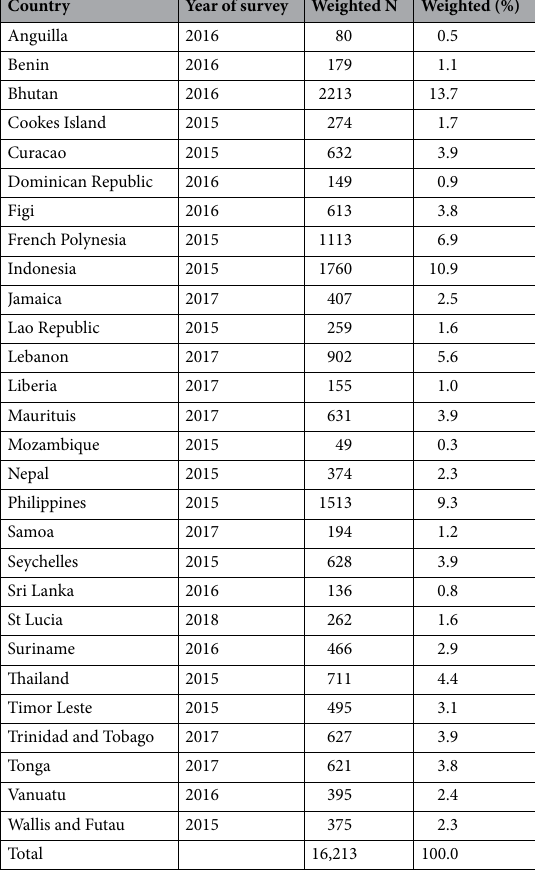
Table 1. Distribution of study sample across countries and